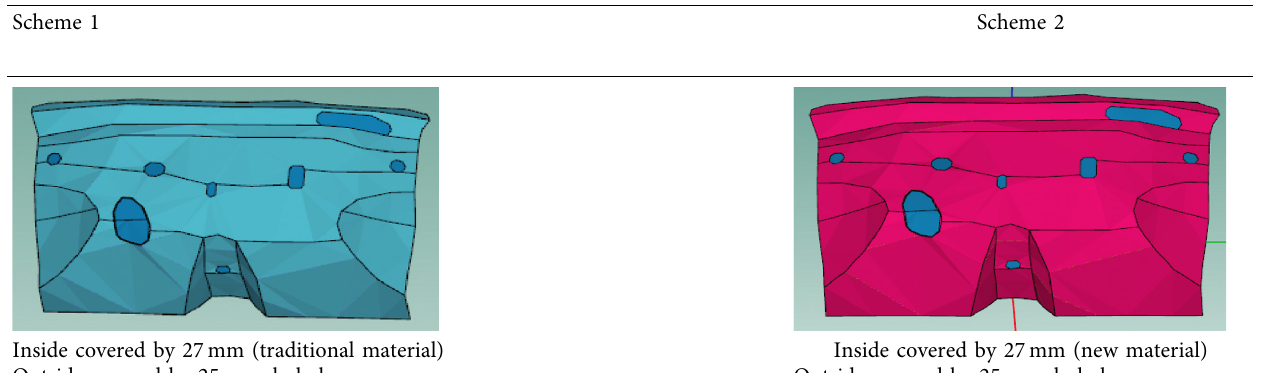
Table 7: Two kinds of covered schemes.